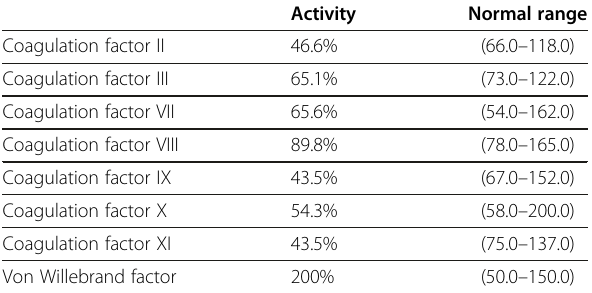
Table 1 Title: coagulation factors